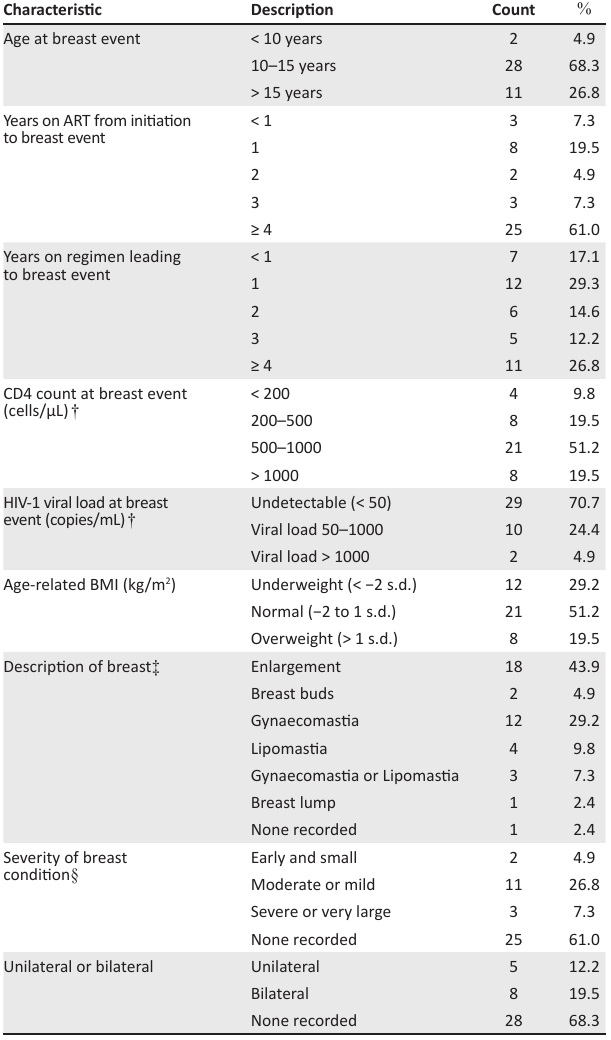
TABLE 2: Demographic and clinical characteristics of patients with abnormal breast events ( n = 41).